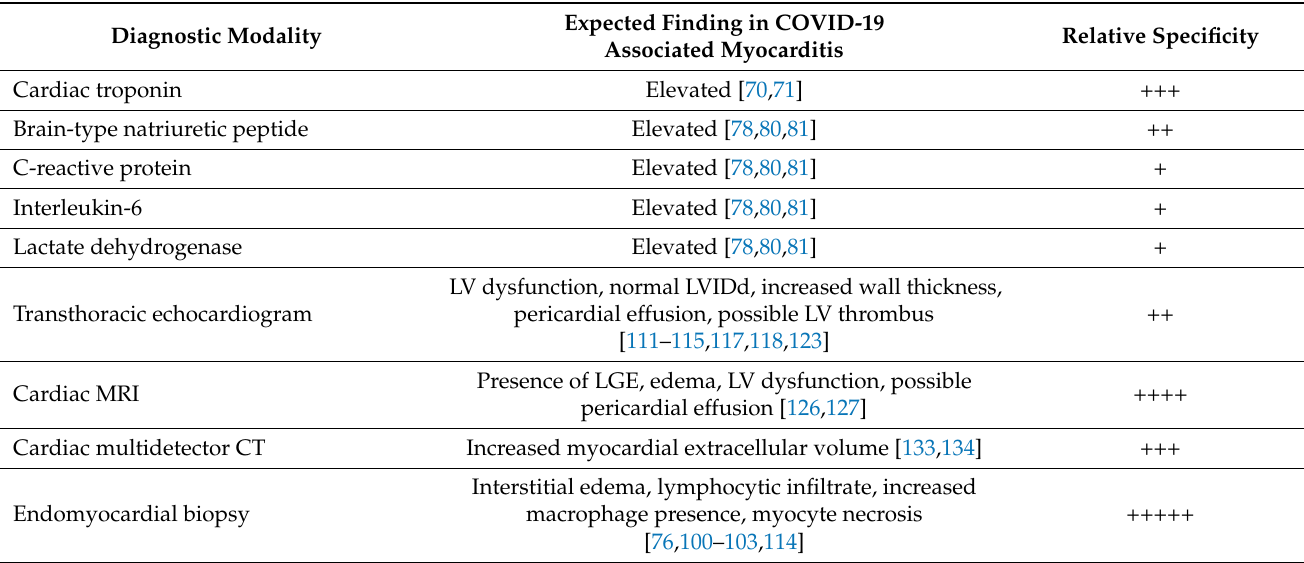
Table 1. Diagnostic modality, expected findings, and relative specificity for COVID-19-associated myocarditis. “+” represents non-specific finding while “+++++” corresponds to high specificity. Expected Finding in